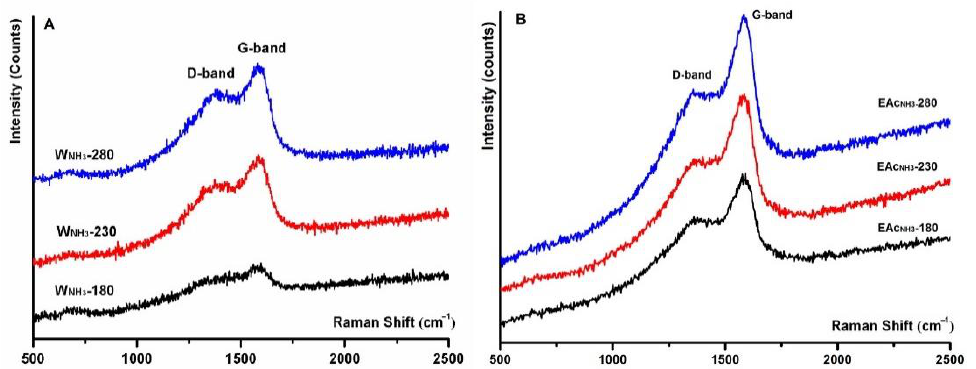
Figure 2. Raman spectra of the Fe 3 O 4 @C nanoparticles W NH3 ( A ) and EAc NH3 ( B ) hydrocarbonized at different temperatures.